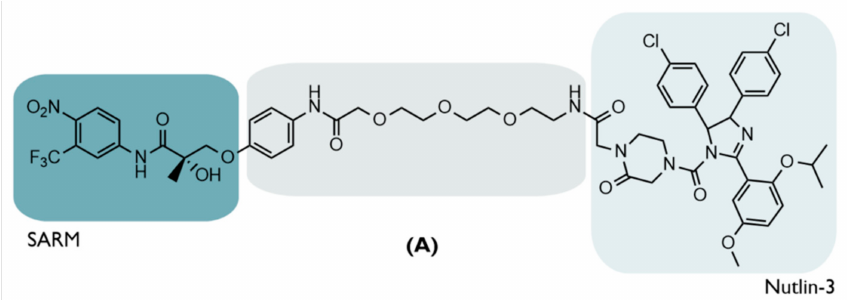
Figure 5. Chemical structure of PROTAC A. The first MDM2-based PROTAC recruits its target, the androgen receptor (AR), through a selective AR modulator (SARM), hydroxyflutamide. This SARM is linked to nutlin-3, which is responsible for recruiting the MDM2, through a linker derived from PEG, with 13 atoms